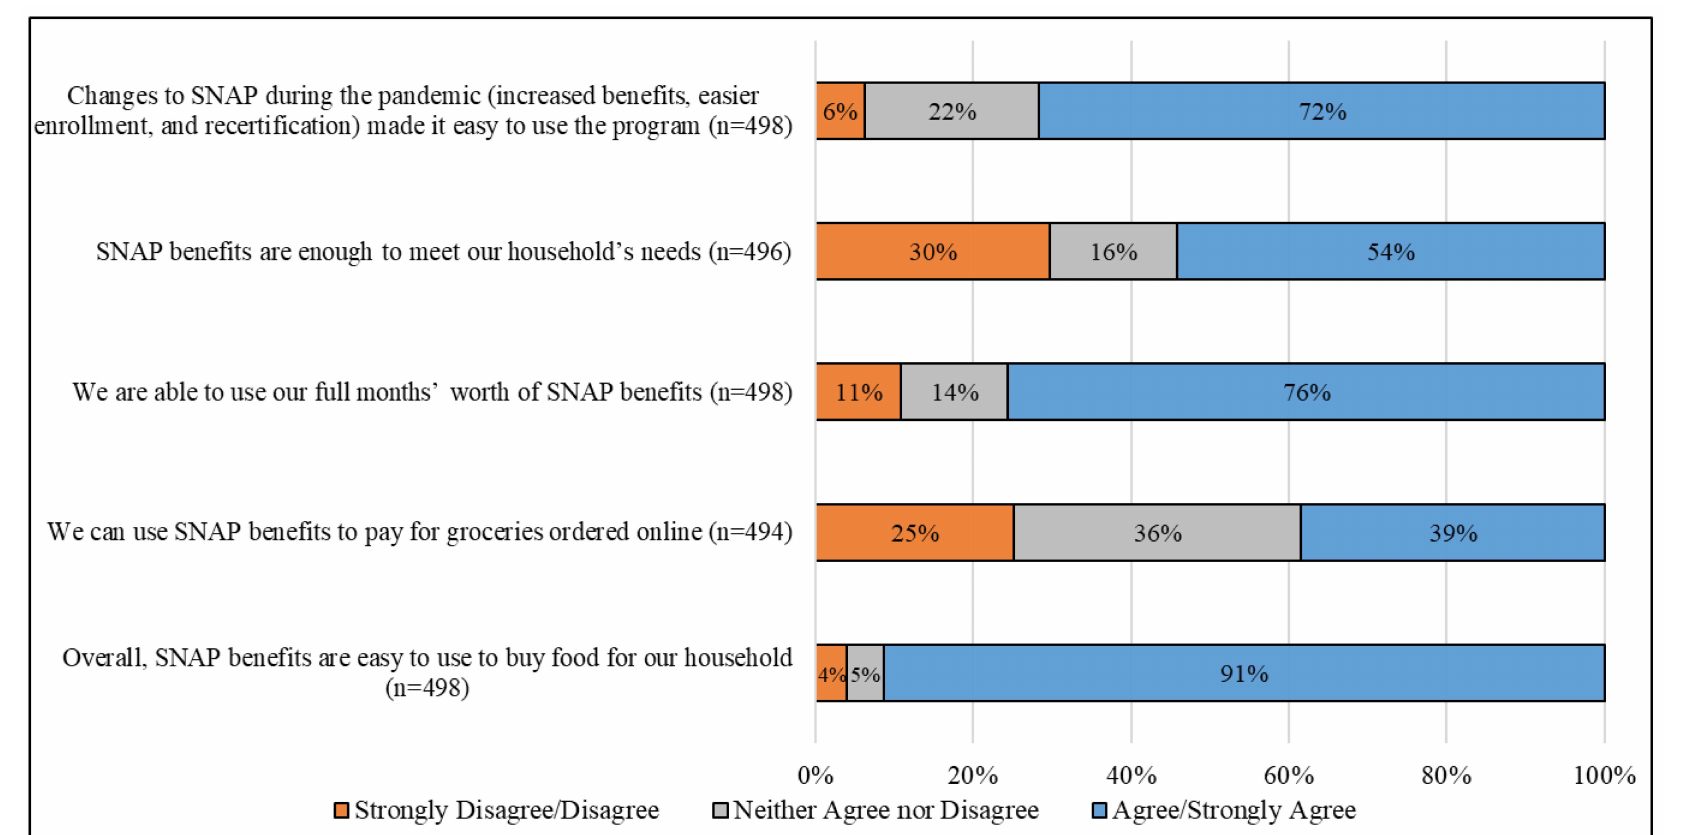
Figure 1. Perceptions of the Supplemental Nutrition Assistance Program (SNAP) use during the Coronavirus Disease 2019 (COVID-19) pandemic † . † Respondent numbers across questions vary due to